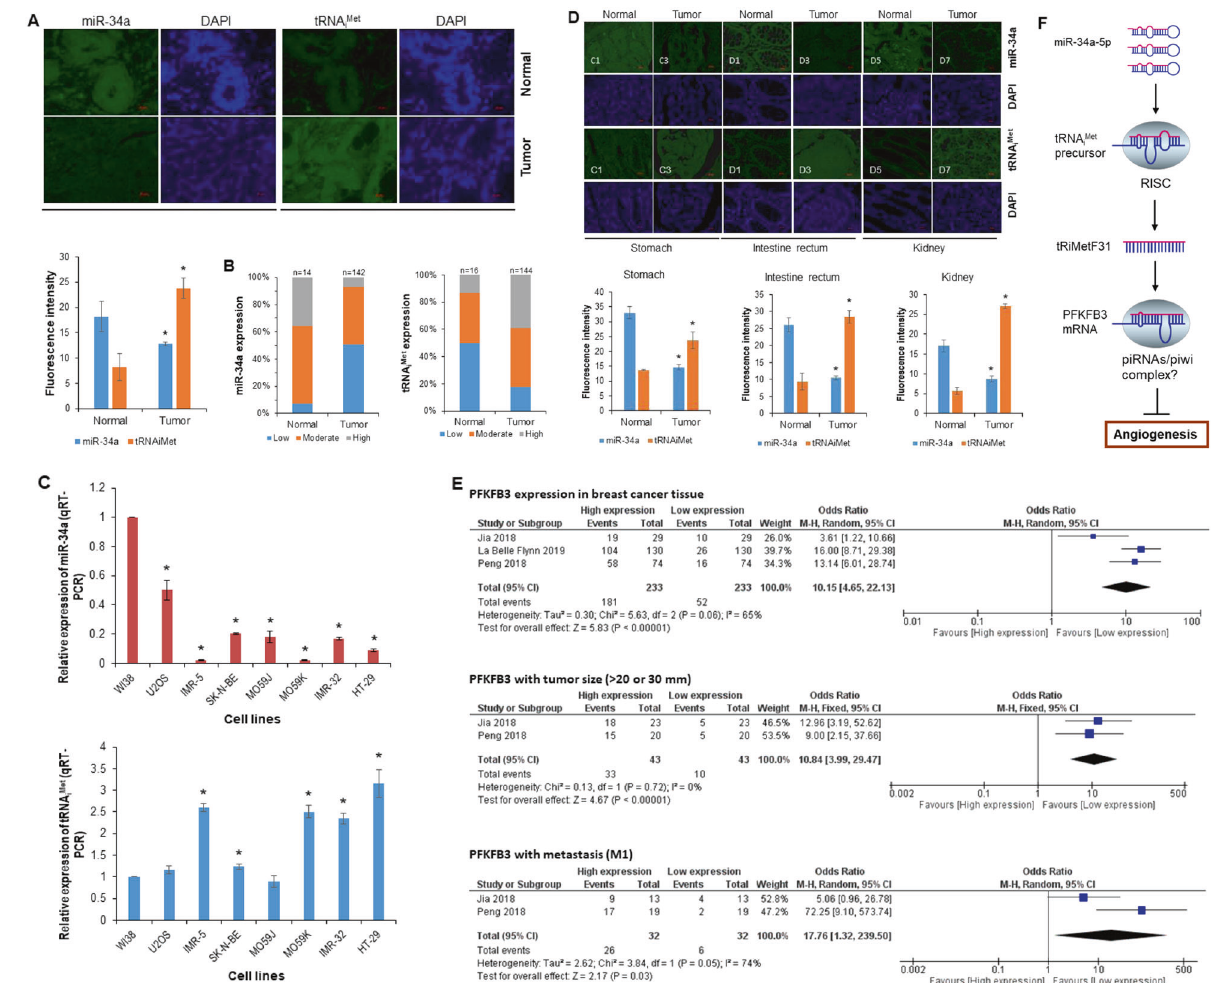
Fig. 7 Expression of miR-34a and tRNA iMet in cancer tissues and cell lines. A Presentative images for expression of miR-34a and tRNA iMet that were determined in breast cancer tissues using FISH, as detailed in the “ Materials and methods ” . B Statistic analysis of miR-34a and tRMA iMet FISH staining. C Total RNA isolated from breast and brain cancer cell lines was subjected to qRT-PCR analysis using primers for either miR-34a or total tRNA iMet . D Representative images for expression of miR-34a and tRNA iMet that was determined in stomach, kidney, and intestinal cancer tissues using FISH as detailed in the “ Materials and methods ” . E A meta-analysis of PFKFB3 expression in breast tumor tissues. F Diagram of the potential role of miR-34a/tRiMetF31/PFKFB3 axis in angiogenic suppression. * indicates P <